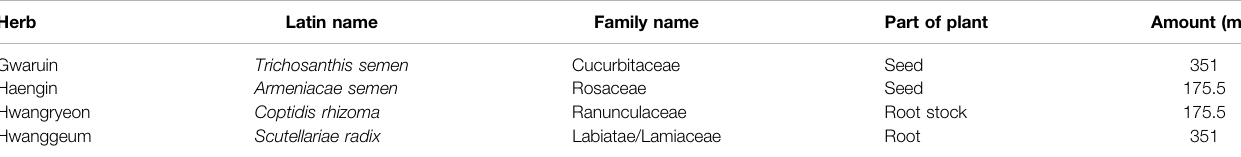
TABLE 1 | Components of GHX02.